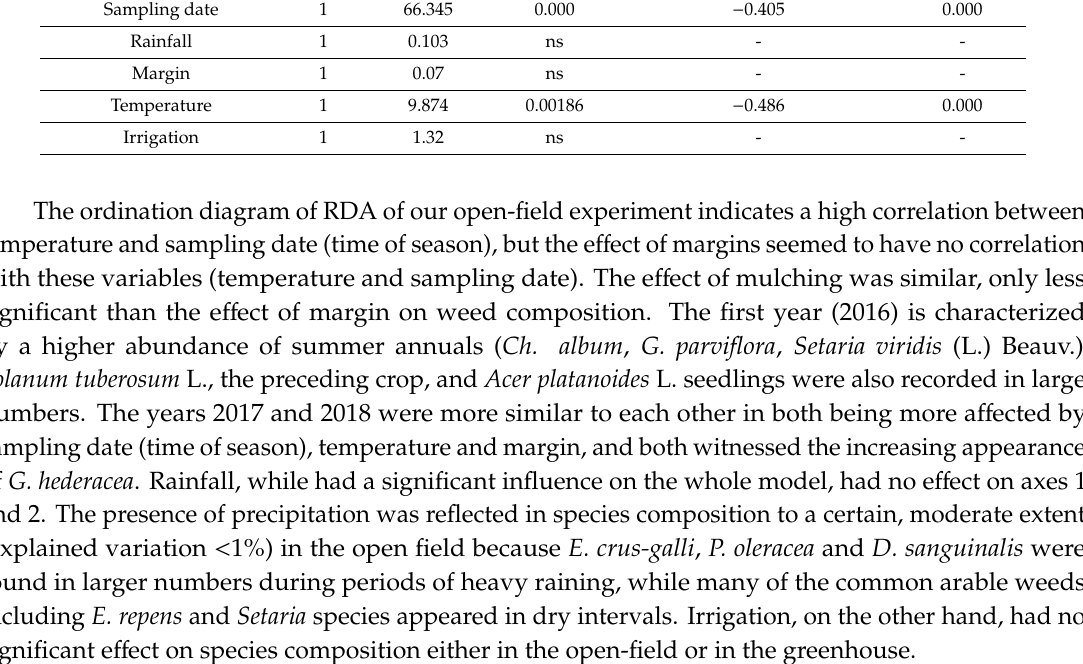
Numeric / Interval